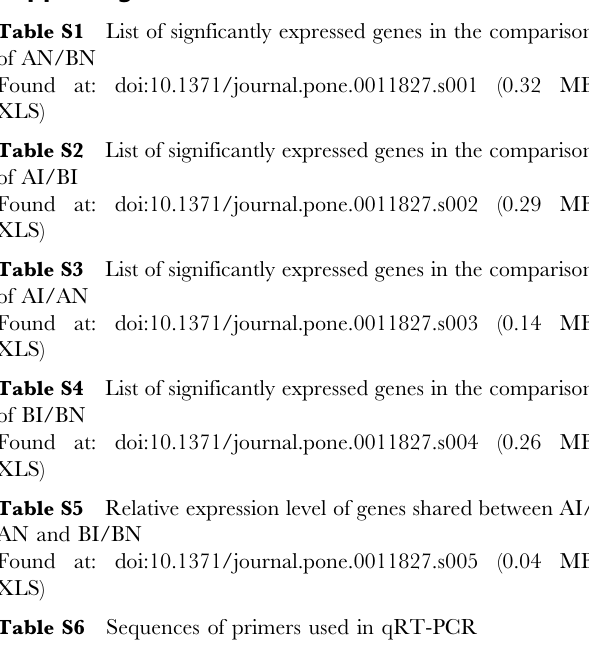
Table S6 Sequences of primers used in